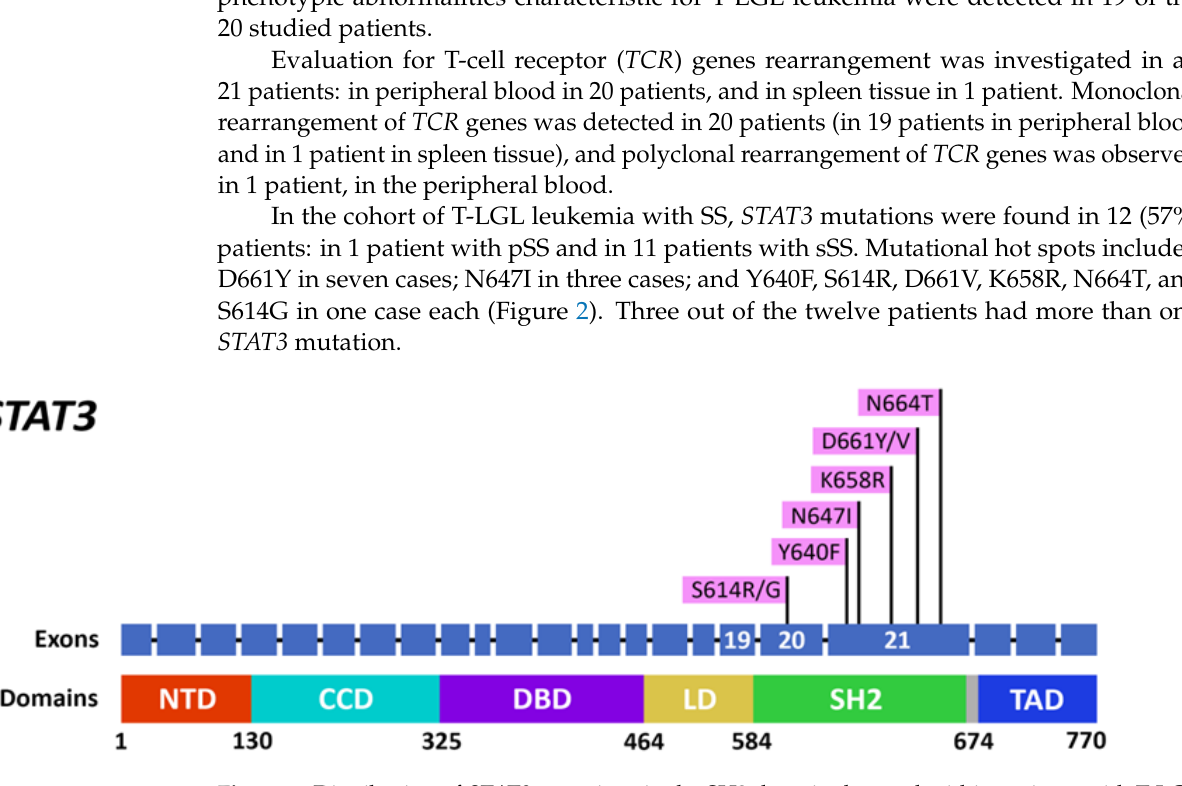
Figure 3. Case #20. Fragment analysis of T-cell receptor beta ( TCR- β ) gene PCR products from the CD4low fraction shows a clonal rearrangement pattern; in contrast, the CD4high fraction shows a polyclonal rearrangement pattern. Integration of the typical immunophenotype with T-cell clonality and clinical man- ifestations allowed us to diagnose T-LGL leukemia in 20 patients according to the crite- ria given by Matutes [15]. In one patient with a polyclonal rearrangement of the TCR